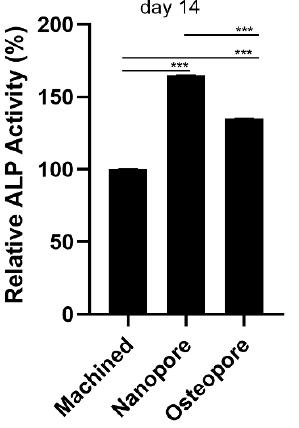
Figure 6. ALP activity of primary human osteoblasts cultured after 14 days. Nanopore and Osteopore surfaces showed higher ALP activity than Machined, +64.97 ± 0.05% and +34,92 ± 0.09% respectively. Data are expressed with relation to cell percentage cultivated on Machined disc as mean ± SD. Standard deviation values resulted between 0.01 and 0.09. (*** p < 0.0001; Machined vs. Nanopore p < 0.0001; Machined vs. Osteopore p < 0.0001; Nanopore vs. Osteopore p < 0.0001).